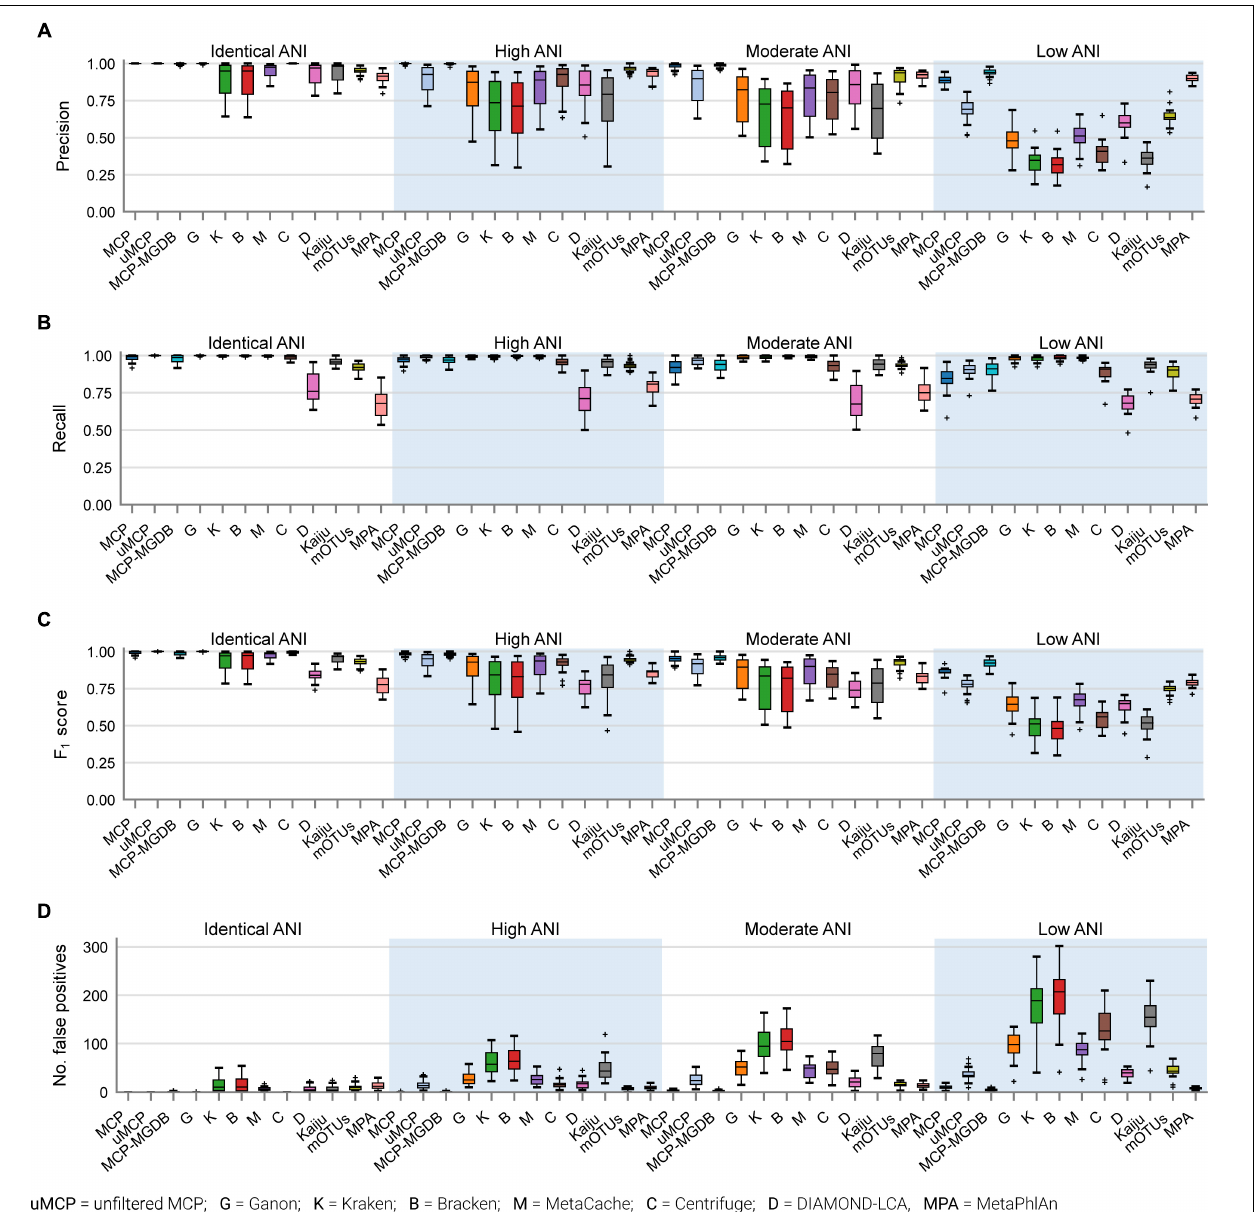
FIGURE 2 | Performance of metagenomic classifiers to predict the presence or absence of species measured using (A) precision, (B) recall, (C) F1 score, and (D) number of false positive predictions on mock communities with decreasing ANI similarity to reference database genomes.